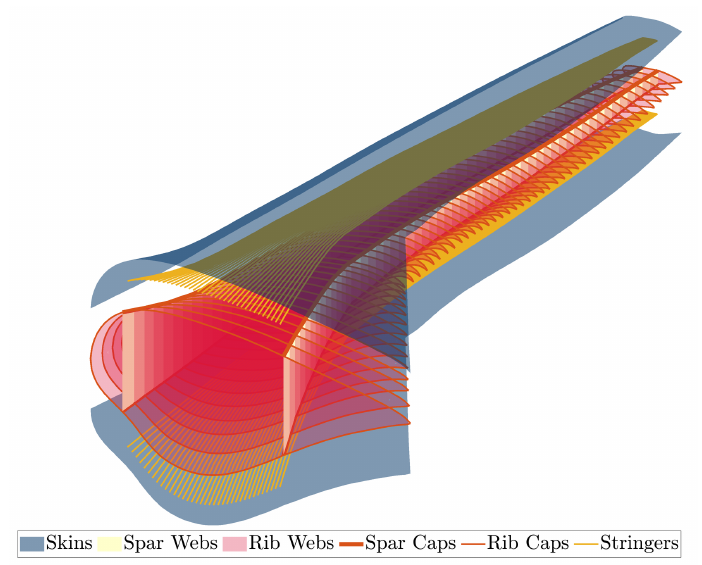
Figure 7. uCRM13.5 internal configuration and